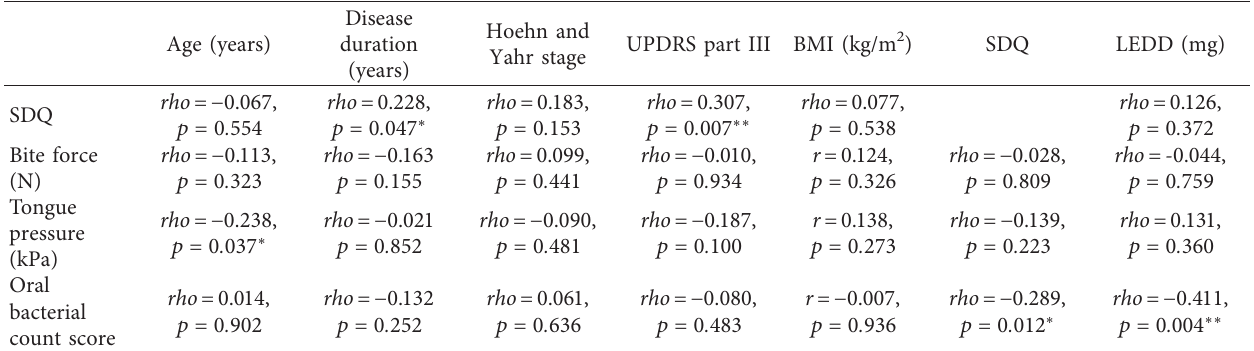
Table 2: Correlations between each measured value and score in the next 56